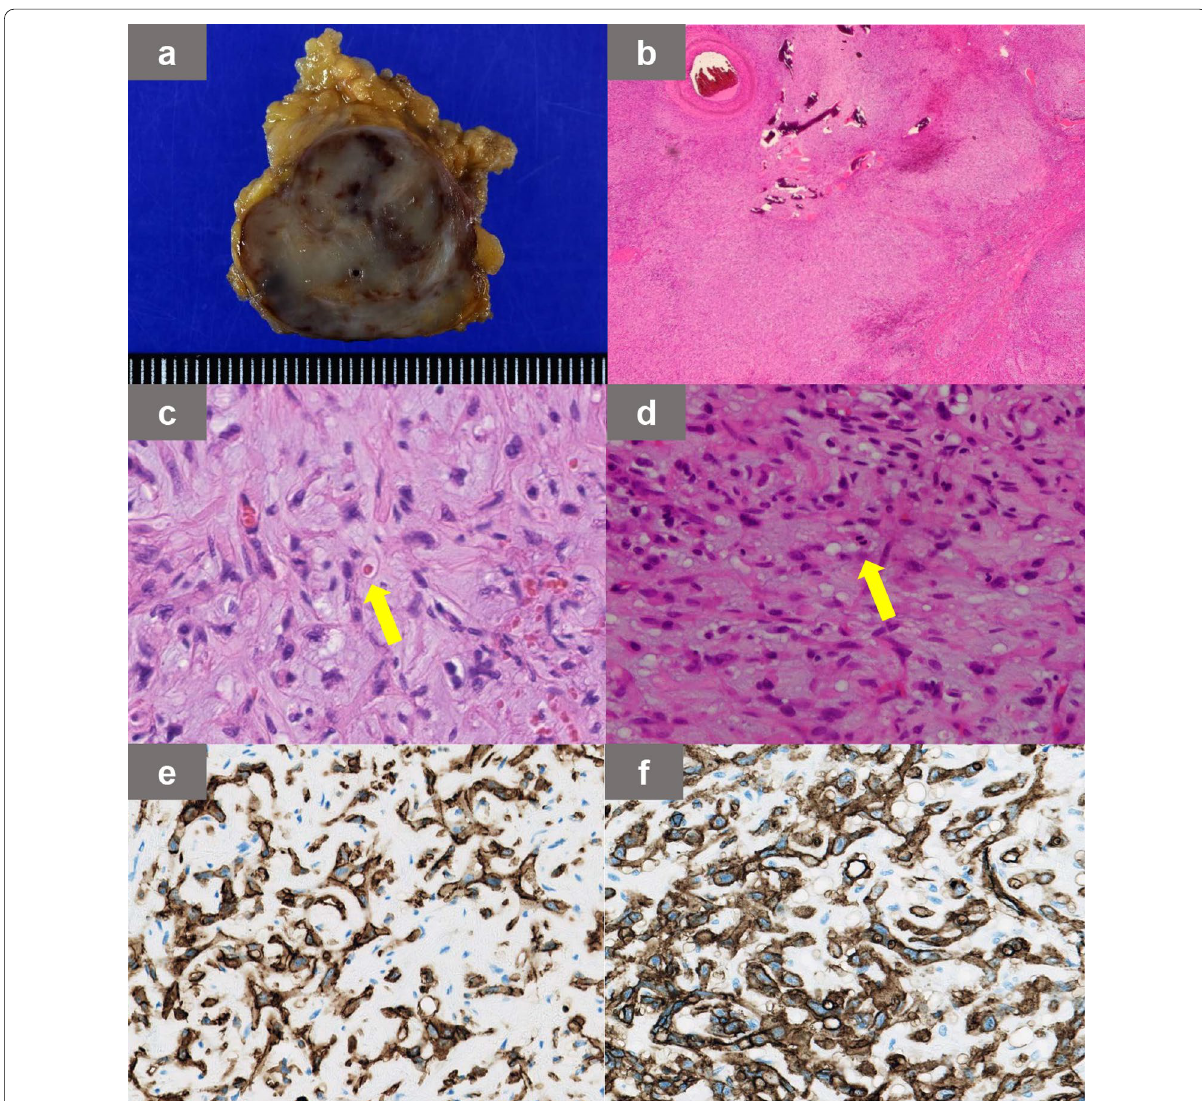
Fig. 5 Histopathological findings of the axillary tumor. a Macroscopic findings of the axillary tumor. b Tumor was angiocentric. c Some tumor cells showed a primitive vascular cavity (arrow) that could contain red blood cells. d Nuclear atypia was marked, and mitotic figures (arrow) of about three cells/2 mm 2 were observed. e , f Immunostaining showed tumor cells to be positive for the vascular markers, CD31 ( e ) and CD34 ( f